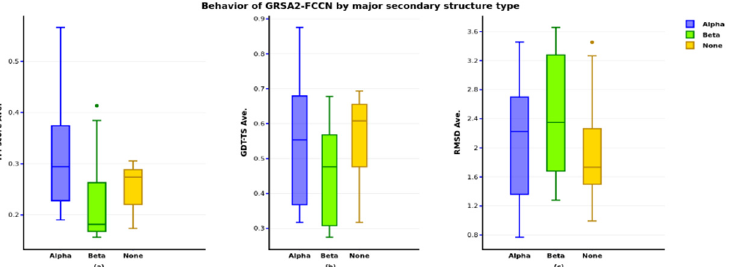
Figure 5. The behavior of GRSA2-FCNN with the majority of secondary structures type in TM-score GDT-TS, and RMSD. ( a ) shows 60 results for instances classified as Alpha, Beta, and None evaluated by TM-score. ( b ) presents 60 results for instances classified in Alpha, Beta, and None evaluated by GDT-TS. ( c ) has 60 results for the instances classified as Alpha, Beta, and None evaluated by RMSD.